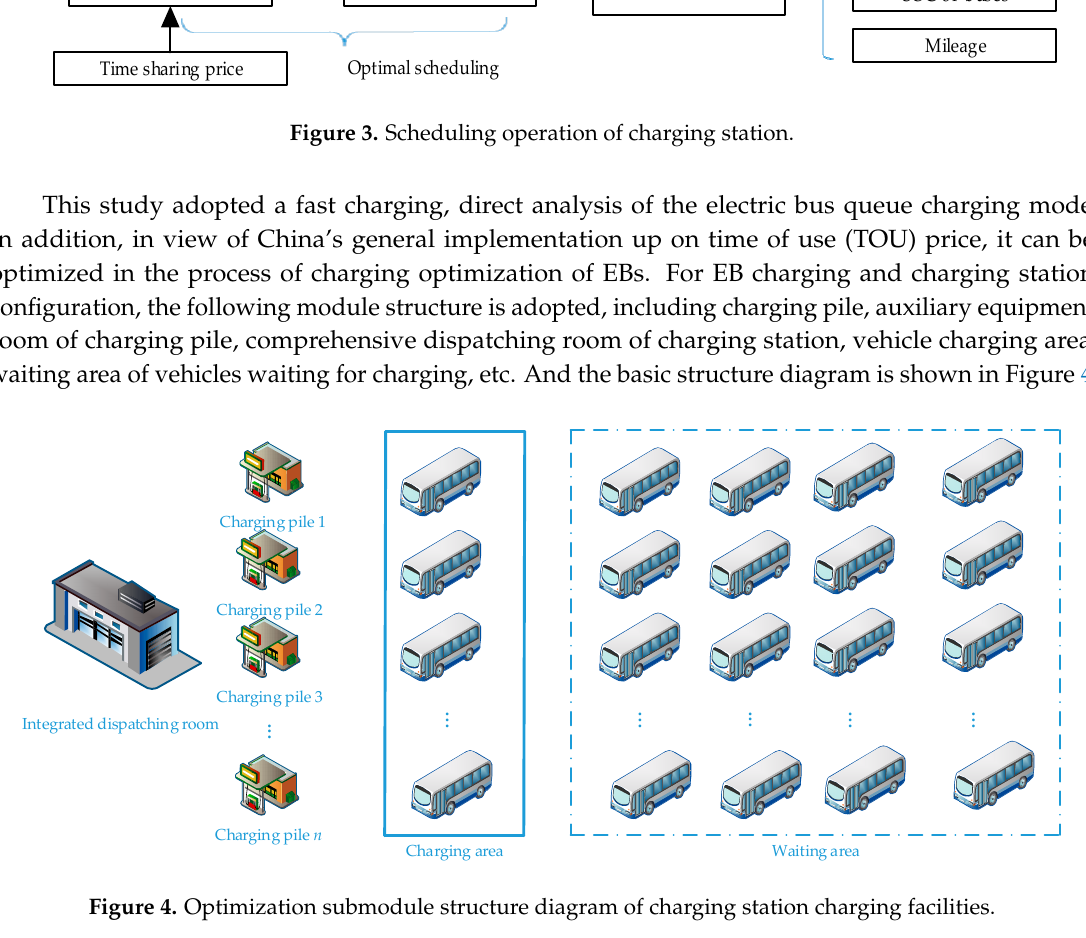
Figure 4. Optimization submodule structure diagram of charging station charging facilities.